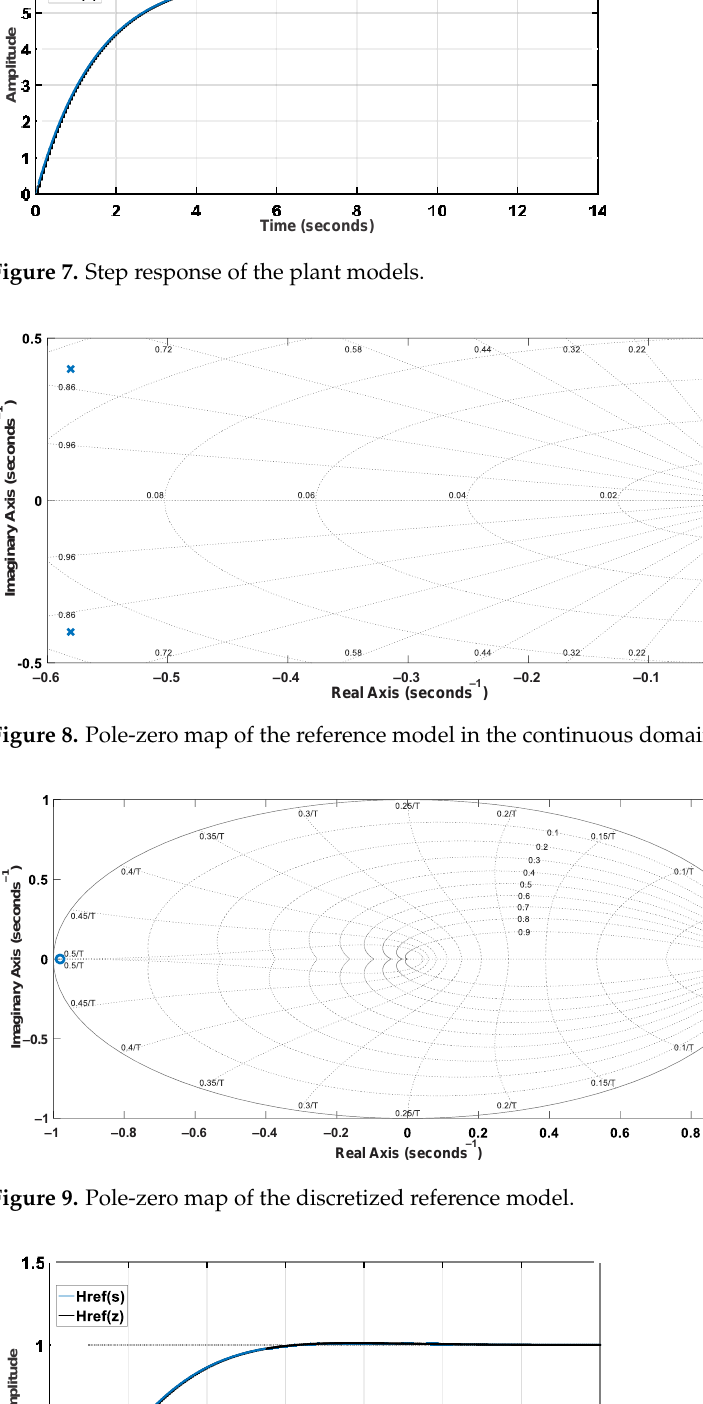
Figure 9. Pole-zero map of the discretized reference model.